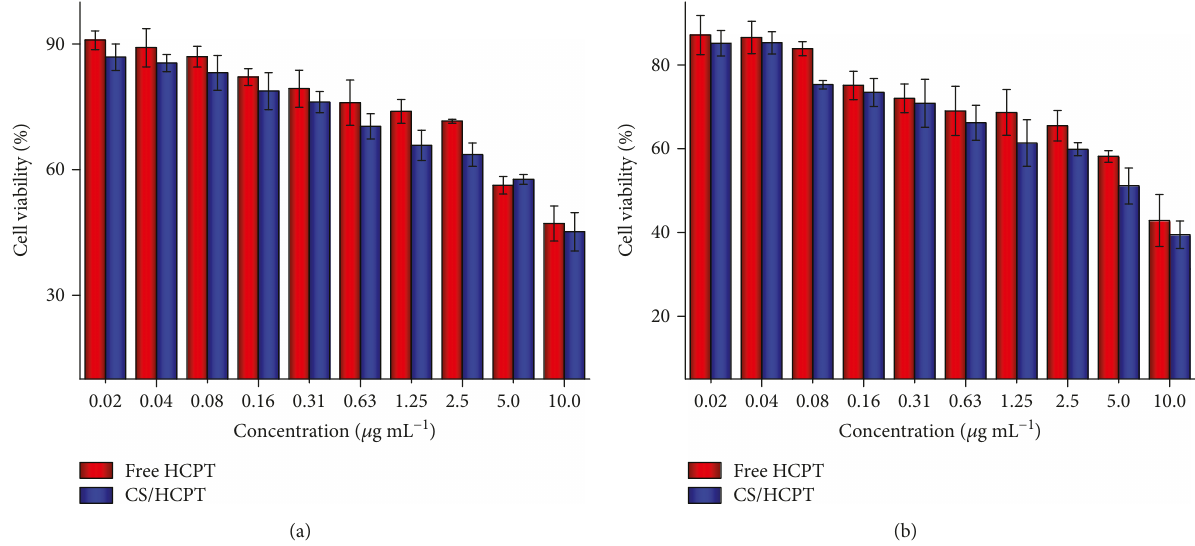
Figure 3: In vitro cytotoxicities of free HCPT and CS/HCPT after incubation with 4T1 cells for 48 h (a) and 72 h